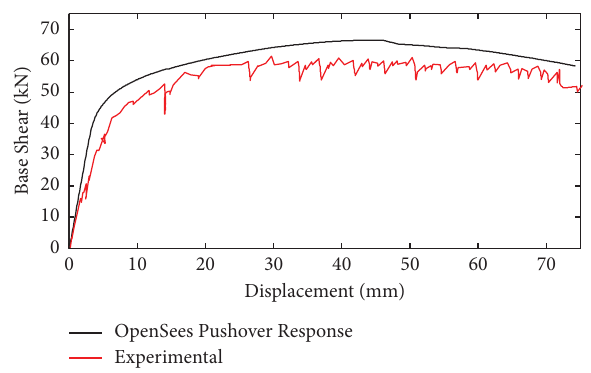
Figure 5: Comparison of numerical and experimental Table 3: General information of ground motions used in loading protocol.